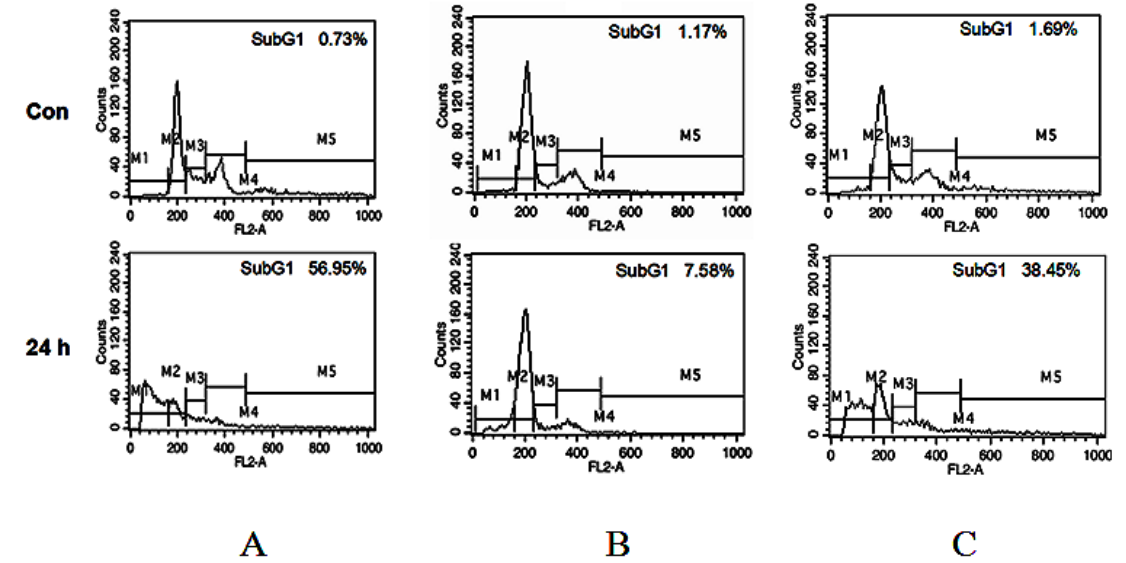
Figure 2. Cell cycle distribution assay. ( A ) MCF-7 cells treated with compound 3b ; ( B ) IOSE144 cells treated with compound 3b ; ( C ) MCF-7 cells treated with positive control (AD-1).